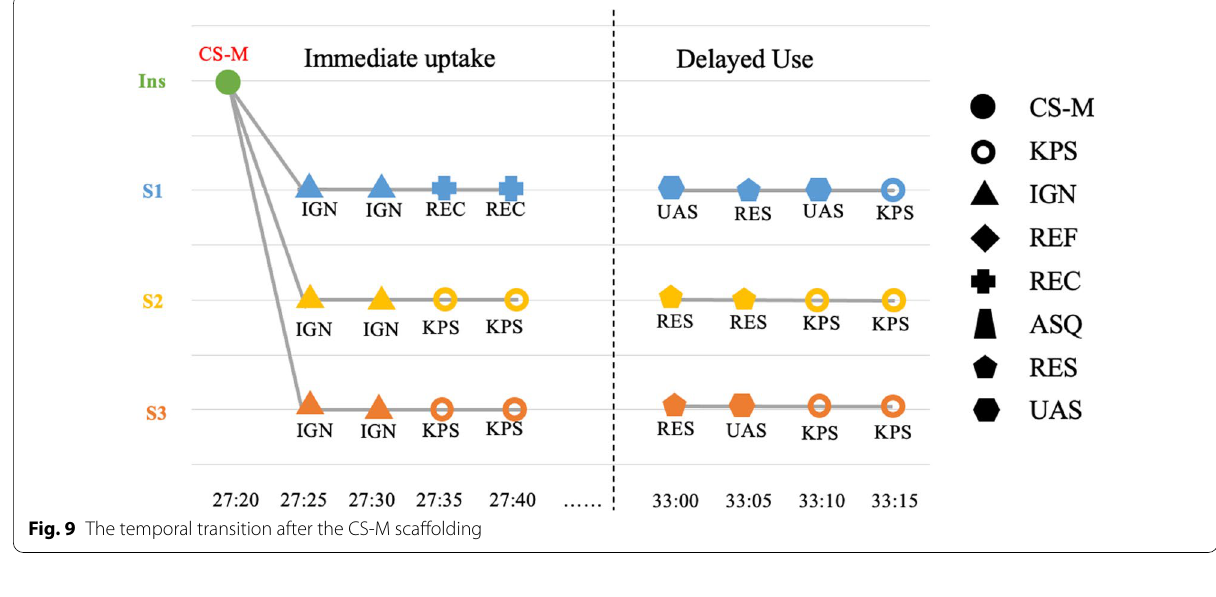
Fig. 9 The temporal transition after the CS-M scaffolding